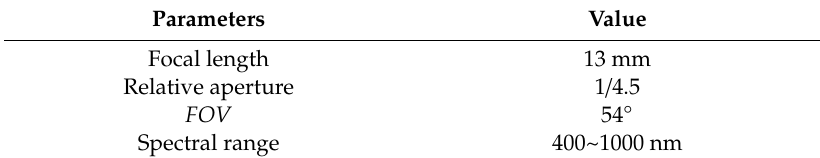
Table 4. Optical parameters of the objective.